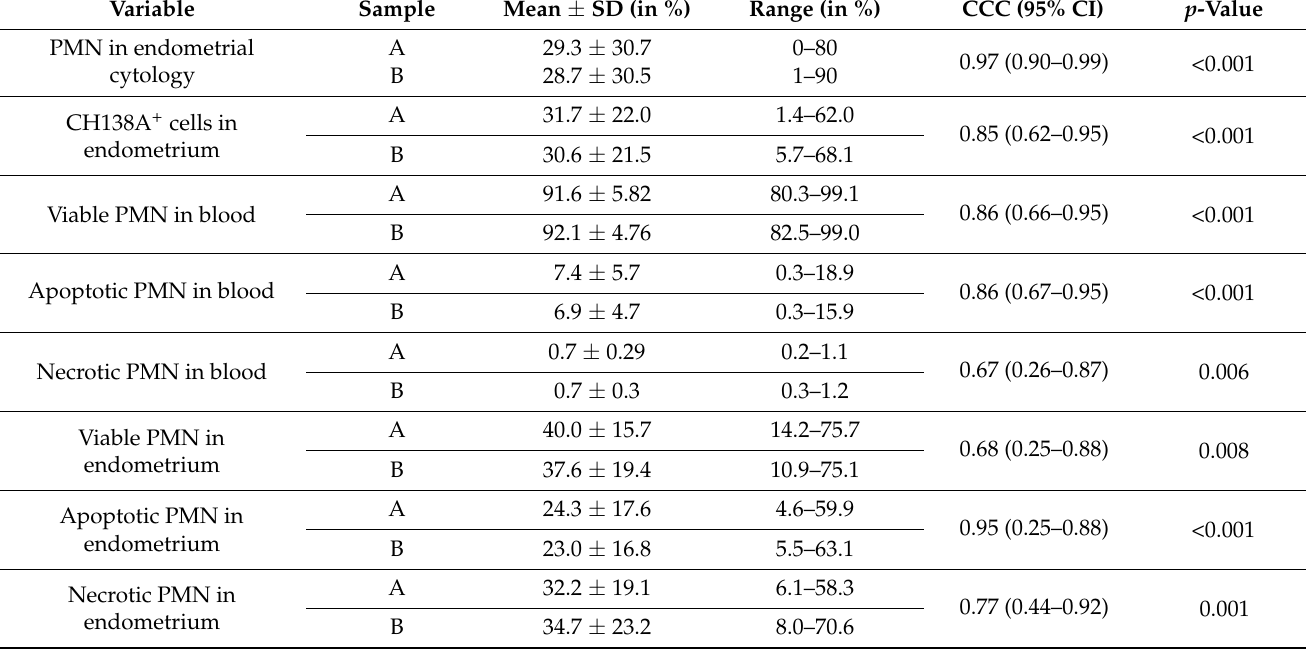
Table 1. Descriptive statistics and reproducibility of identification of polymorphonuclear leukocytes (PMN) in endome- trial samples (cytology and endometrial cell suspensions), and viability assessment of PMN isolated from blood